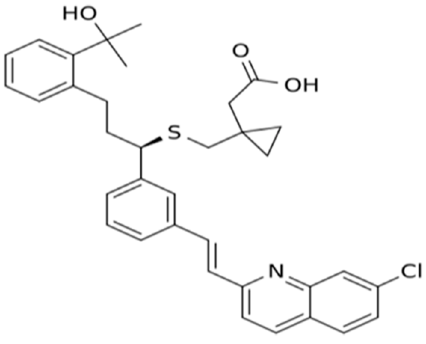
Figure 2. Chemical structure of montelukast (Reprinted from Ref. [27]).